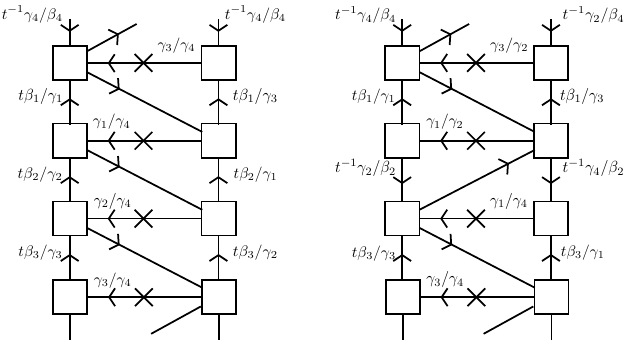
Figure 5 . Domain walls of type T = (cid:13) related to SU( k ) (cid:13) (cid:13)uxes. The left one is related to the (cid:13)ux F = ( (cid:0) 1 = 4 ; (cid:0) 1 = 4 ; (cid:0) 1 = 2 ; 1) (cid:13) and the right one is related to the (cid:13)ux F = ( (cid:0) 1 = 2 ; 1 = 2 ; (cid:0) 1 = 2 ; 1 = 2) (cid:13) in the 6d SU( k ) (cid:13)